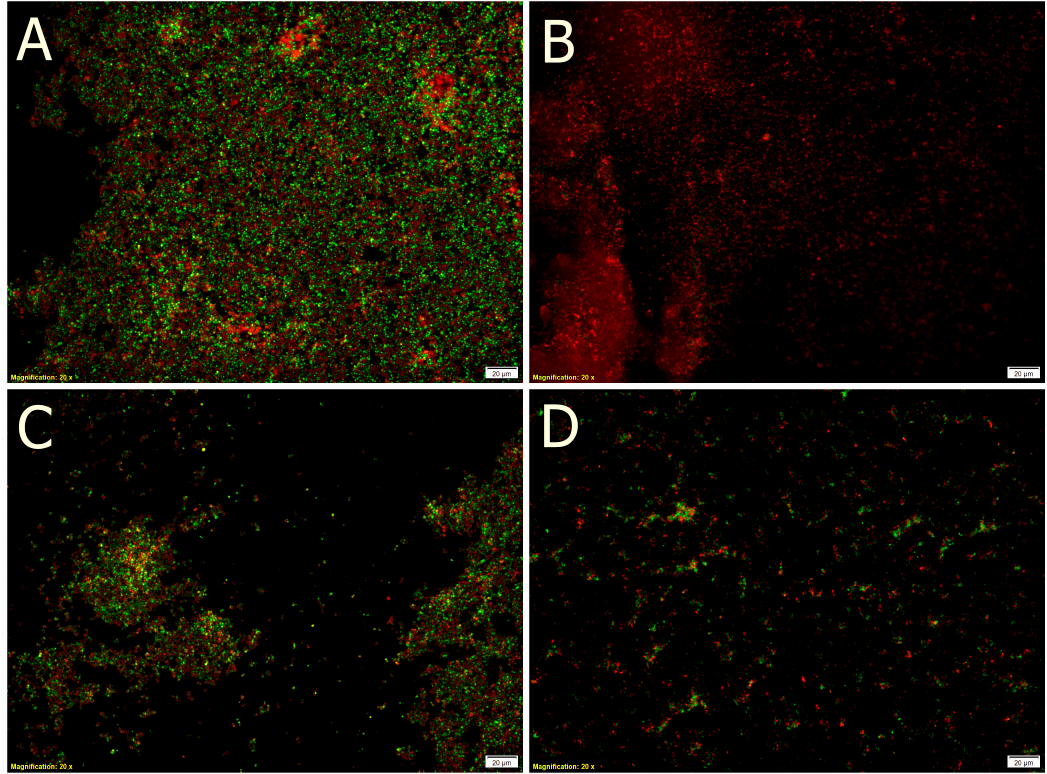
Figure 4. Microscopic observation of the biofilms formed in: ( A ) control (minimal medium); ( B ) medium with cornelian cherry juice; ( C ) medium with lingonberry juice; ( D ) medium with elderberry juice. According to the literature, proanthocyanidins in cranberry and lingonberry juice are